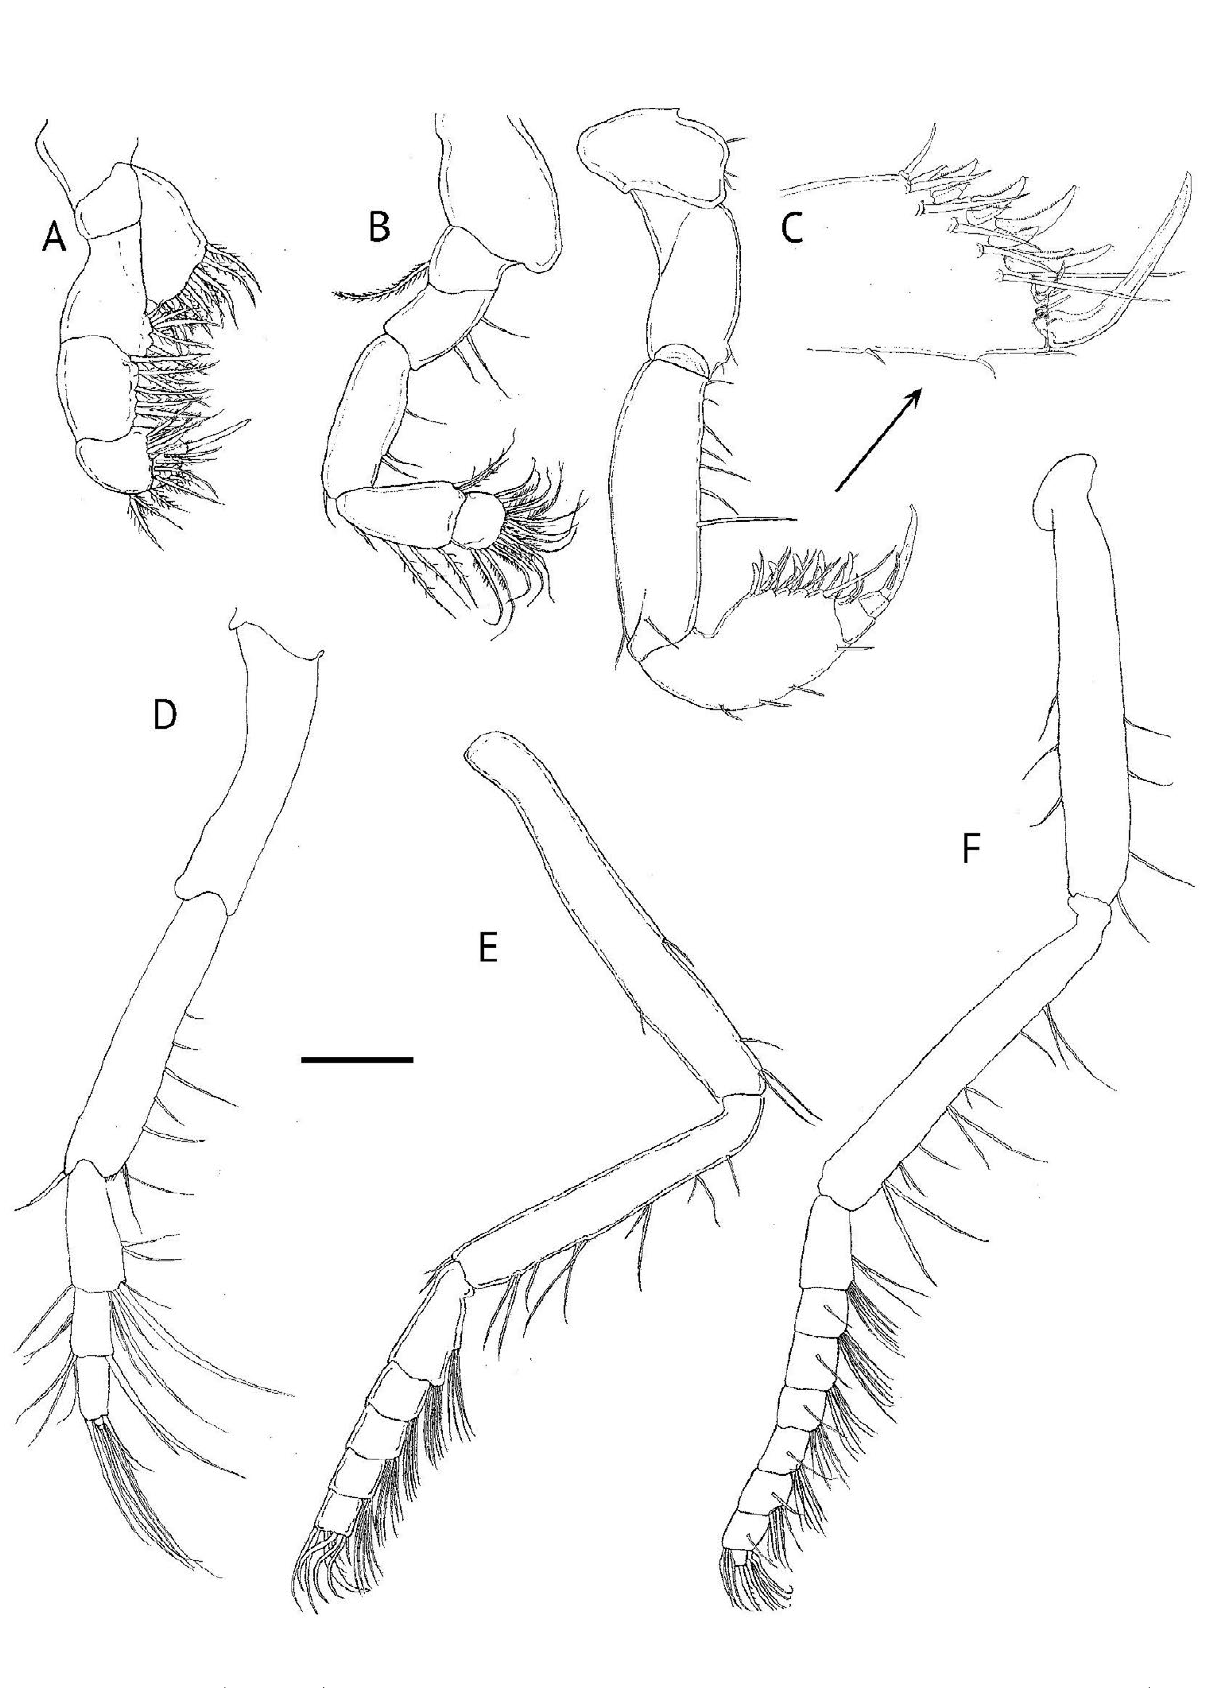
Figure 3. Heteromysis ( Olivemysis ) cocoensis n. sp. adult male, 3.0. mm. A, B. Thoracic endopods 1, 2. C. Thoracic endopod 3 (lateral view) with enlargement of distal end (mesial view). D–F. Thoracic endopods 4, 7, 5. Scale: A, B, D–F, 0.1 mm; C, 0.15